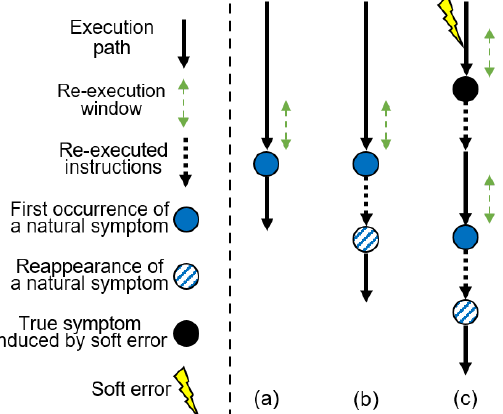
Figure 2. ( a ) Execution traces of a program running unprotected, and a program execution path on a ReStore-protected processor ( b ) without and ( c ) with a soft error. Upon the observation of a symptom, the ReStore architecture re-executes the instructions in the re-execution window (last 100 instructions). It ignores the symptom if it happens again; otherwise, it is assumed that a soft error is detected and